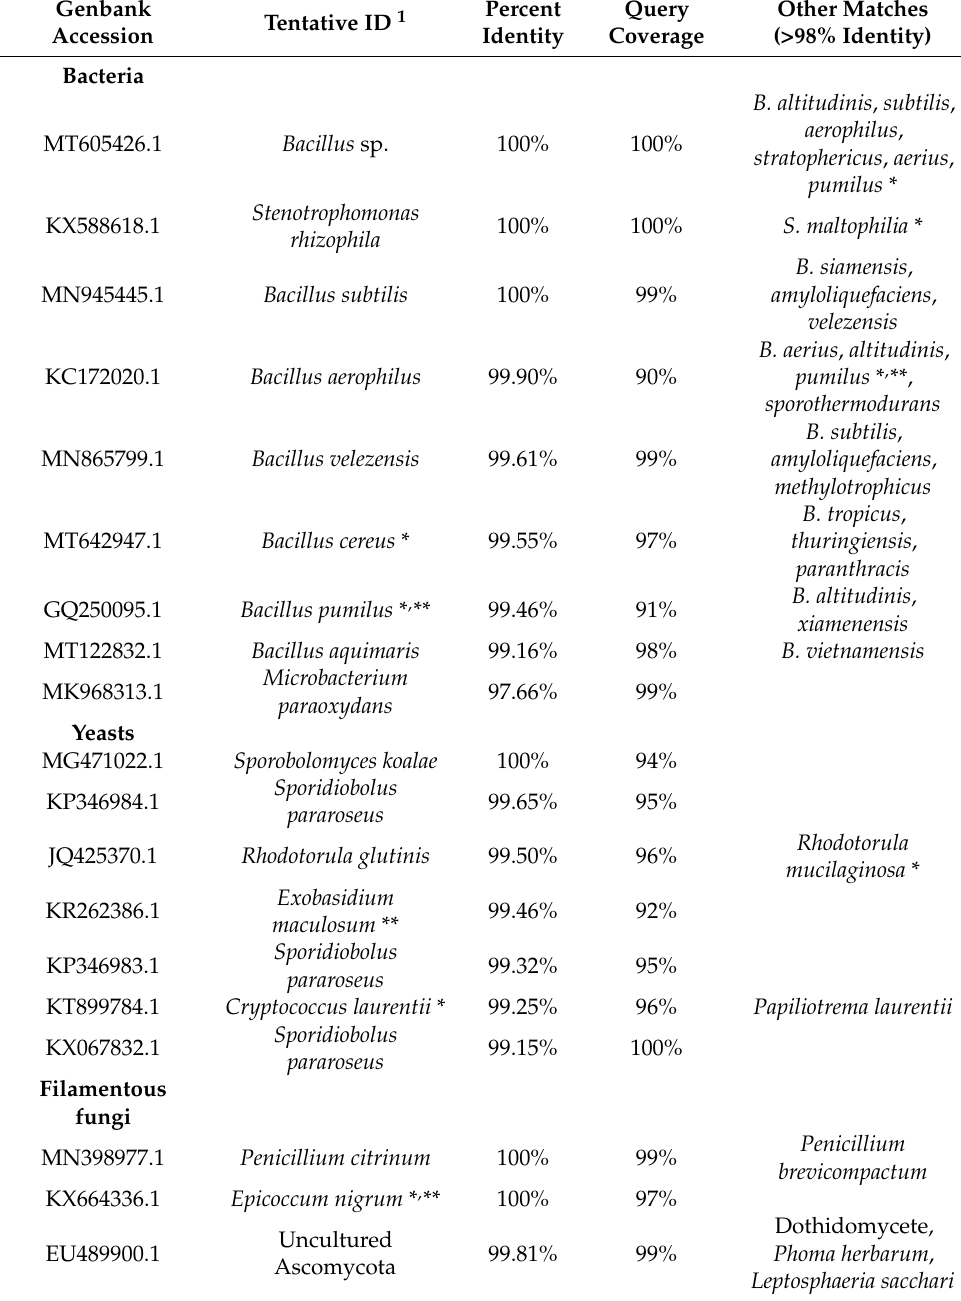
Table 5. Presumptive identity of representative bacterial, yeast, and mold isolates obtained from blueberry mechanical harvester surfaces between 2015 and